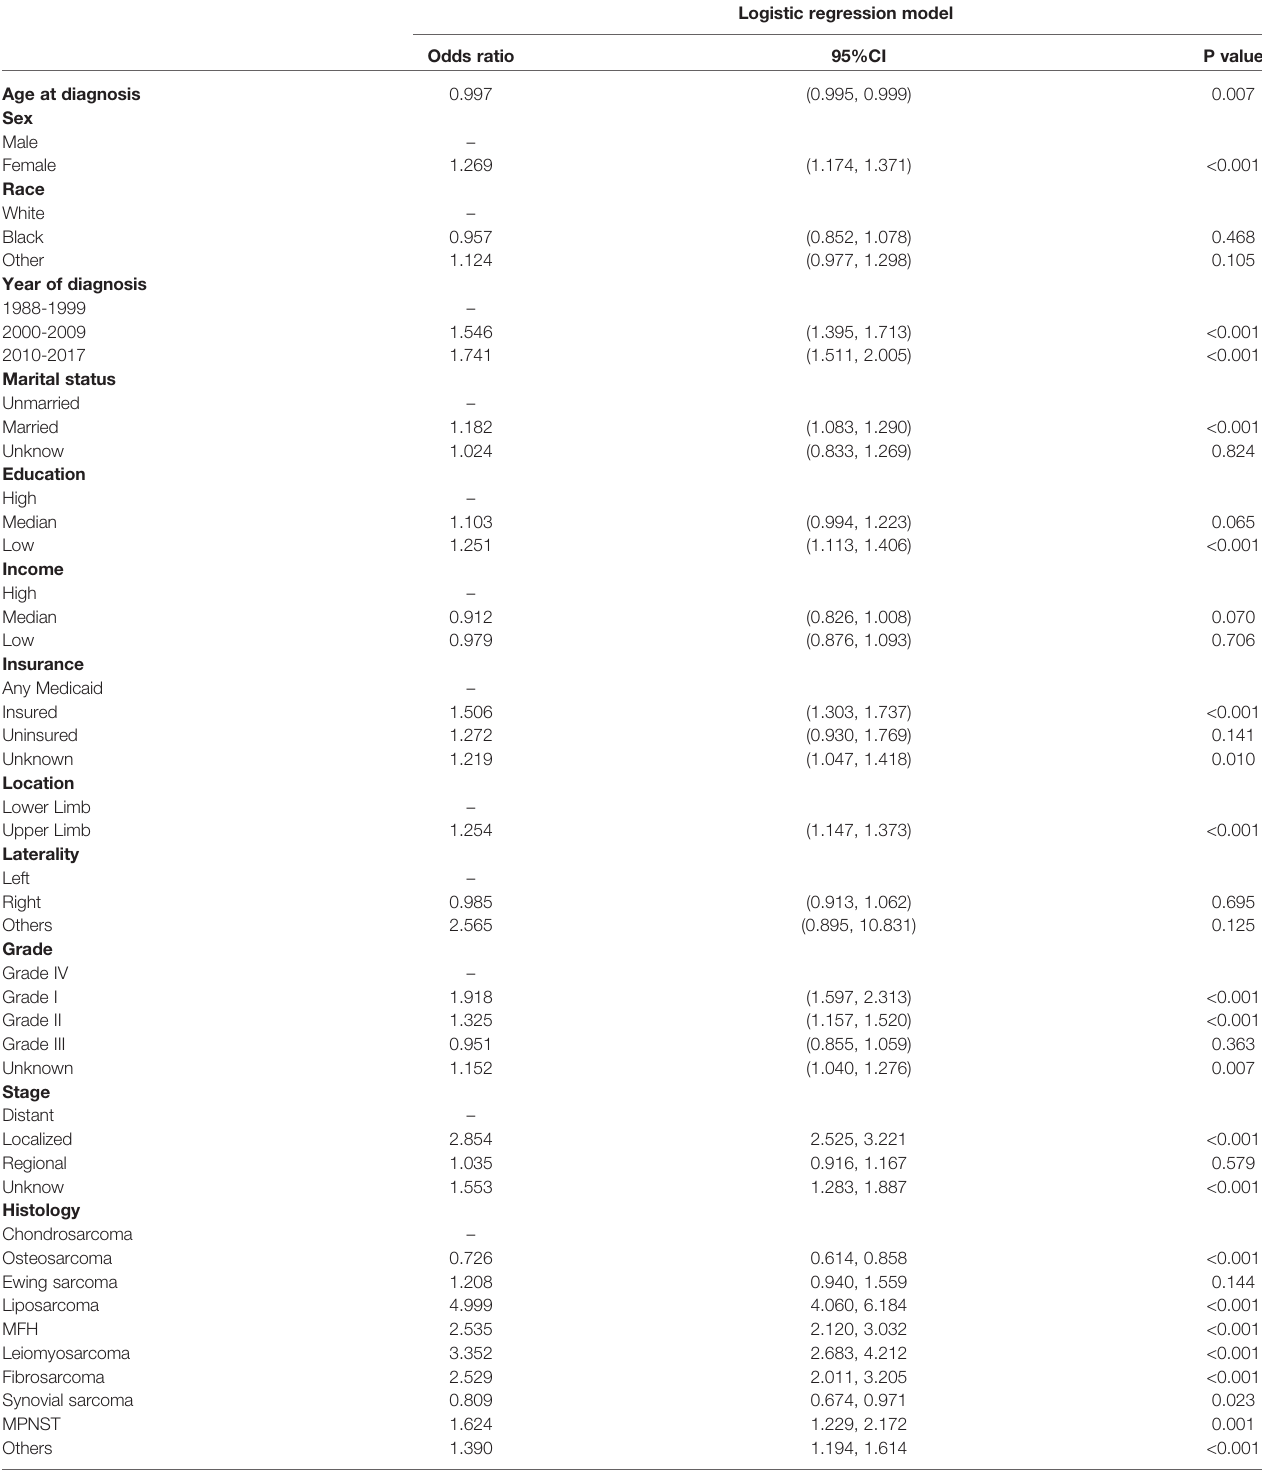
TABLE 2 | Odds ratios of limb salvage procedures compared with amputation among patients with sarcomas.